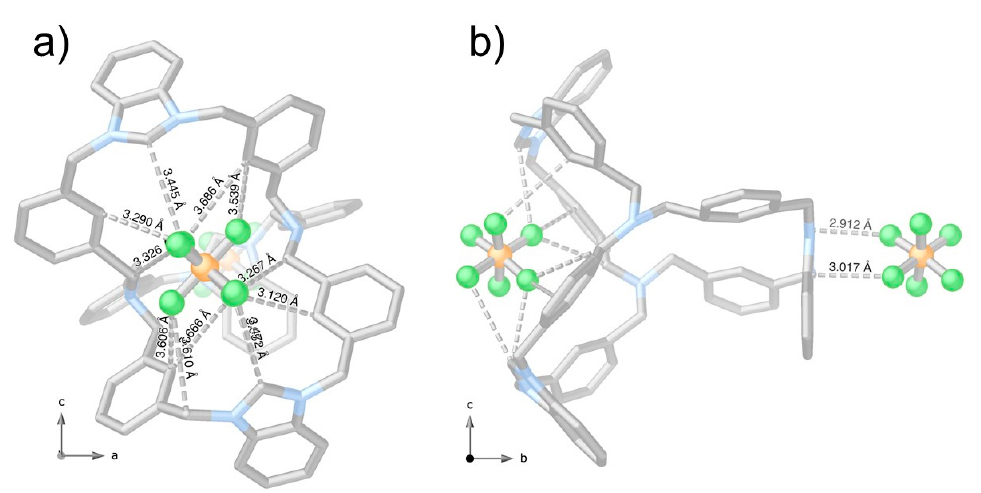
Figure 1. Crystal structure of 1 (PF 6 ) 3 along b and a crystallographic axes, see subfigures ( a , b ), respectively. Hydrogen atoms and one of the three PF 6 − counterions have been omitted for clarity.